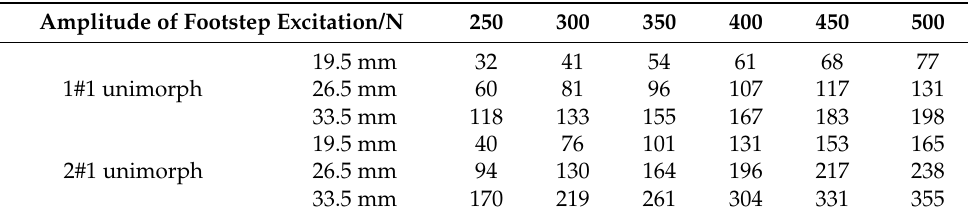
Table 2. Peak-to-peak voltages (V) from 1#1 and 2#1 PZT4 patches ( f = 1 Hz).